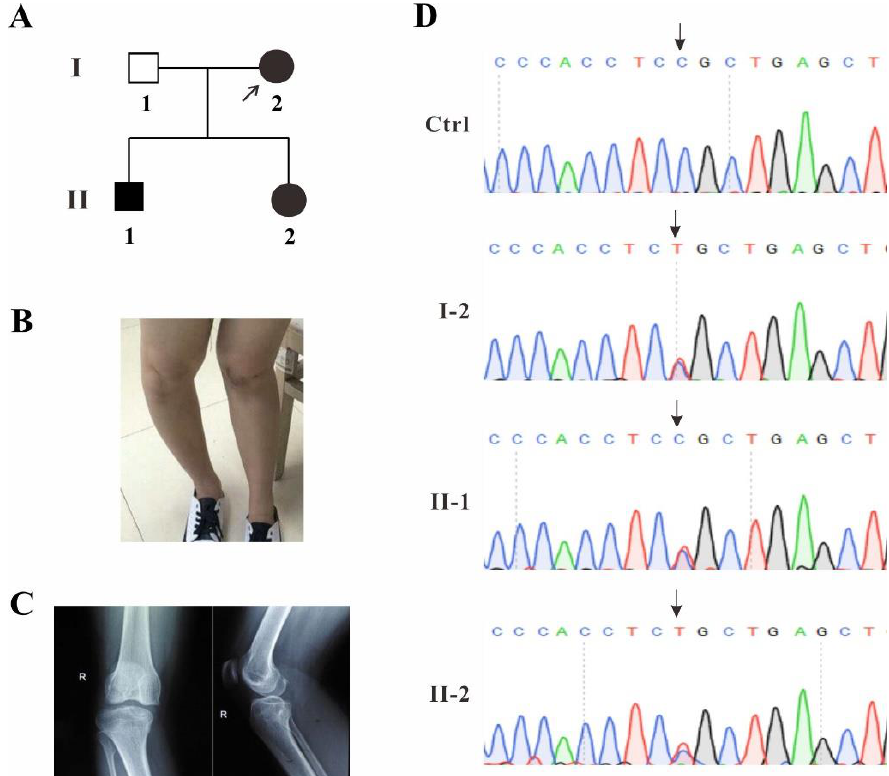
Figure 1. Analysis of a novel TBX4 mutation. ( A ) The pedigree of the family with three patients and the proband is indicated by arrow. ( B ) Leg appearance photo of the proband I-2. ( C ) X-ray report of the proband I-2. ( D ) Sanger sequencing results from the three patients and a healthy control, the mutation sites are indicated by arrows.